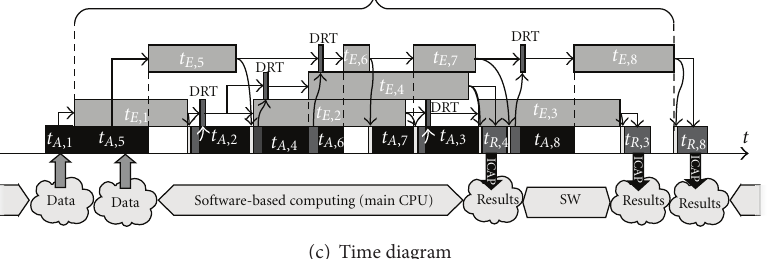
Figure 11: Reusing partial results with